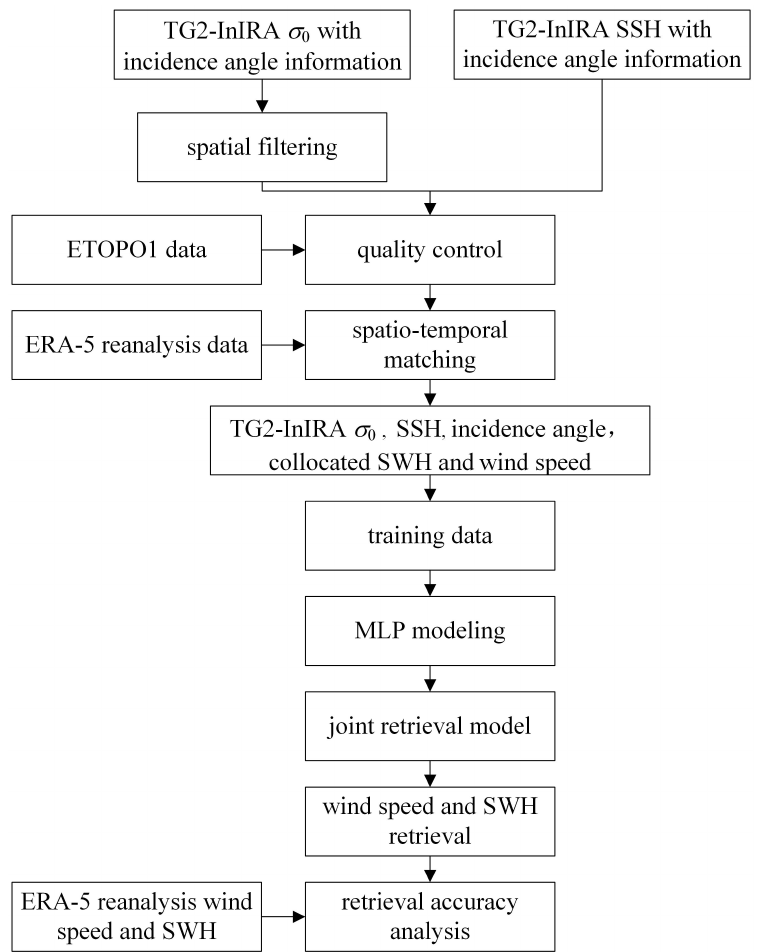
Figure 8. Block diagram of the proposed joint retrieval